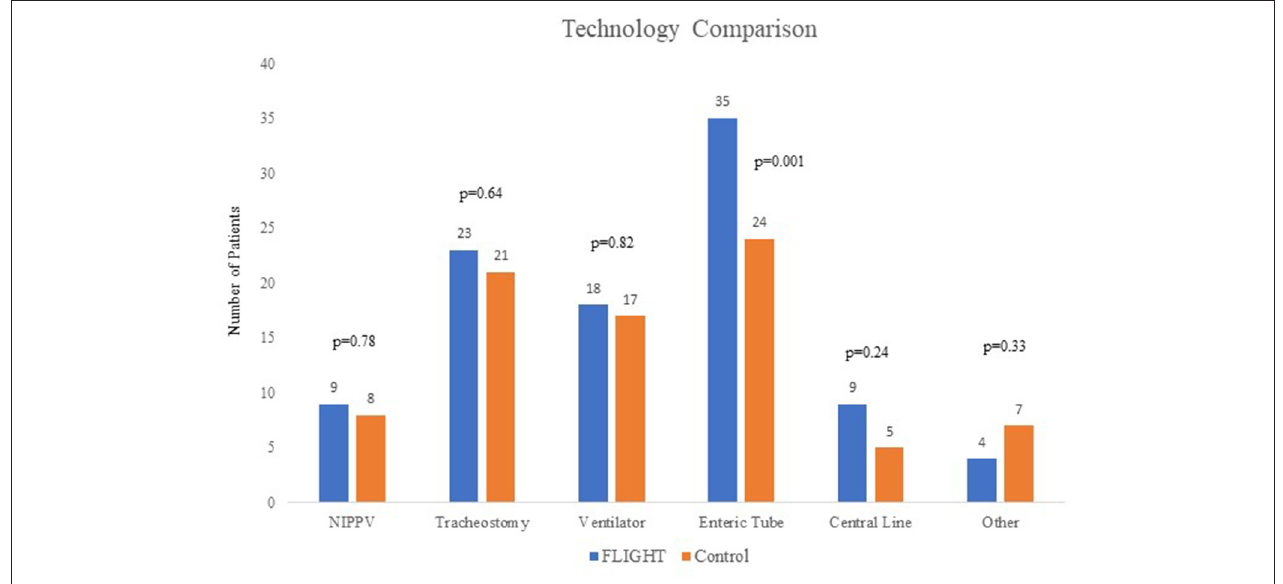
FIGURE 1 | Technology dependence of FLIGHT and control patients.